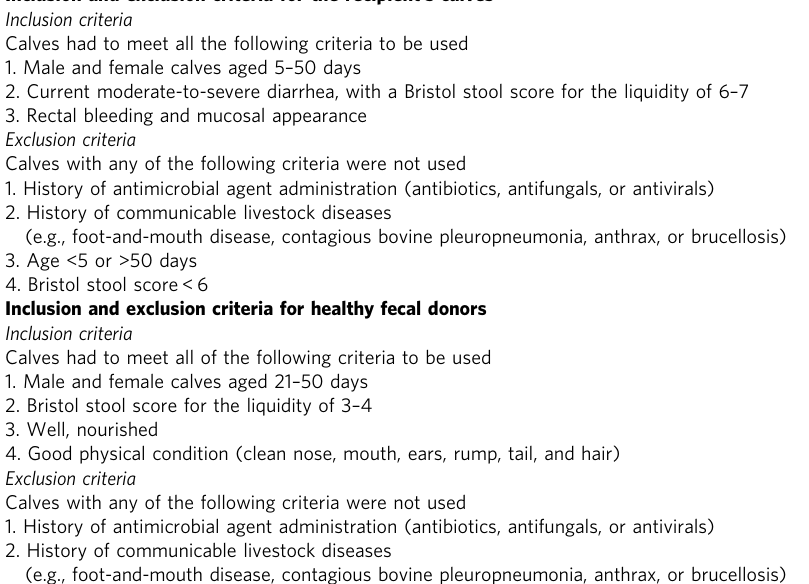
Table 1 Inclusion and exclusion criteria for the donor and recipient ’ s calves. Inclusion and exclusion criteria for the recipient ’ s calves Inclusion